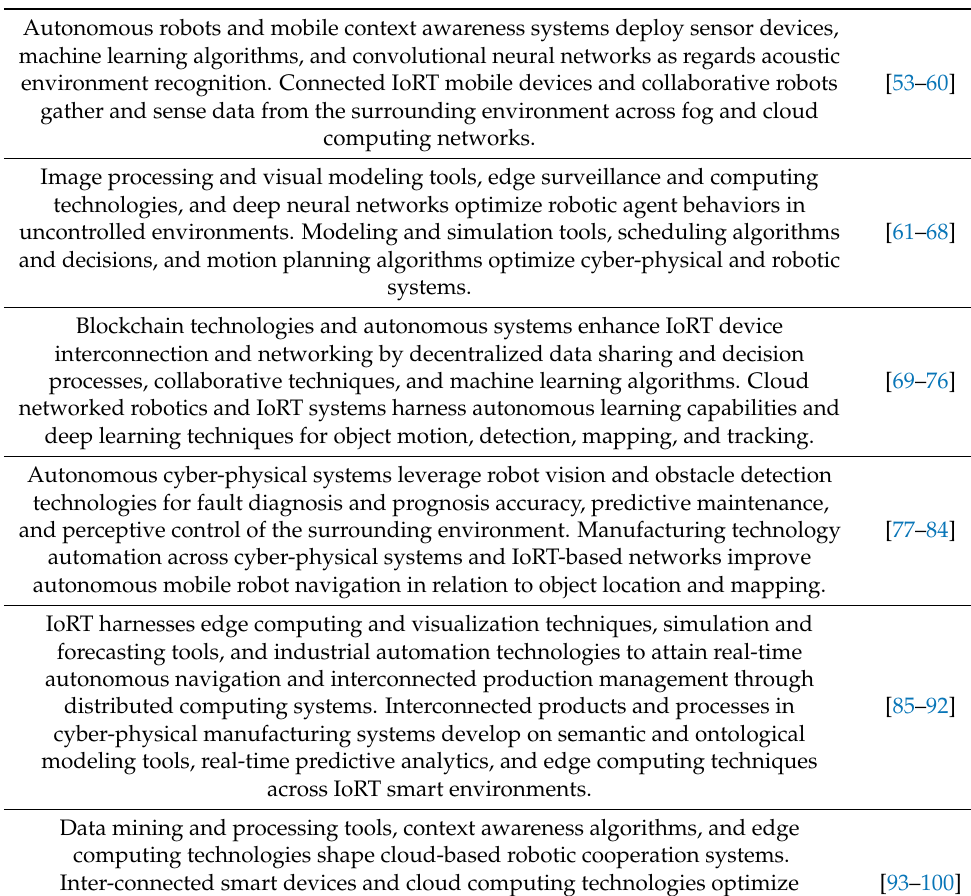
Table 4. Synopsis of evidence as regards analyzed topics and descriptive outcomes (research findings).